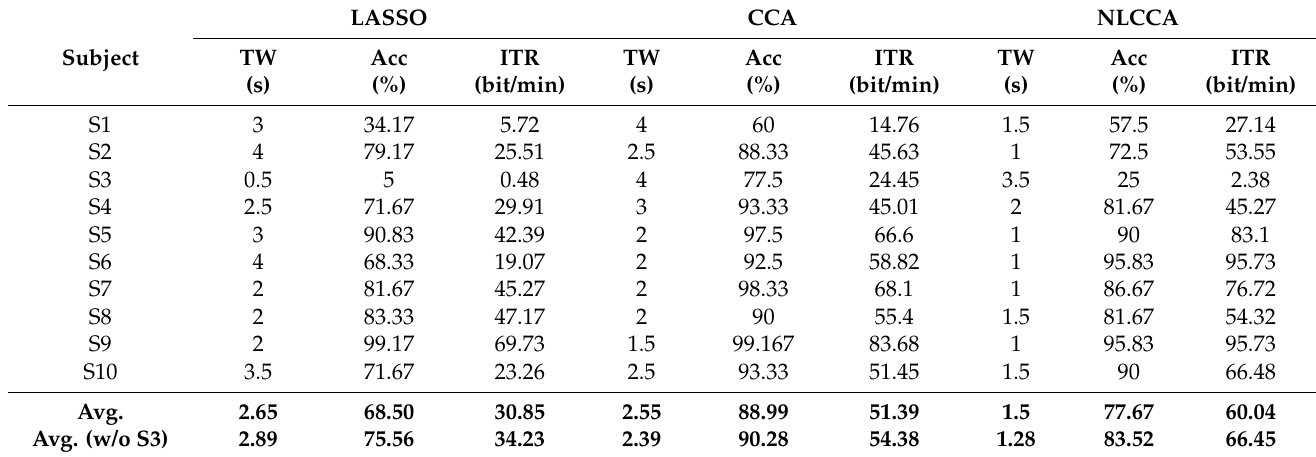
Table 1. Maximum ITR value for each user related to each method, and the corresponding accuracy and time window values. LASSO CCA NLCCA